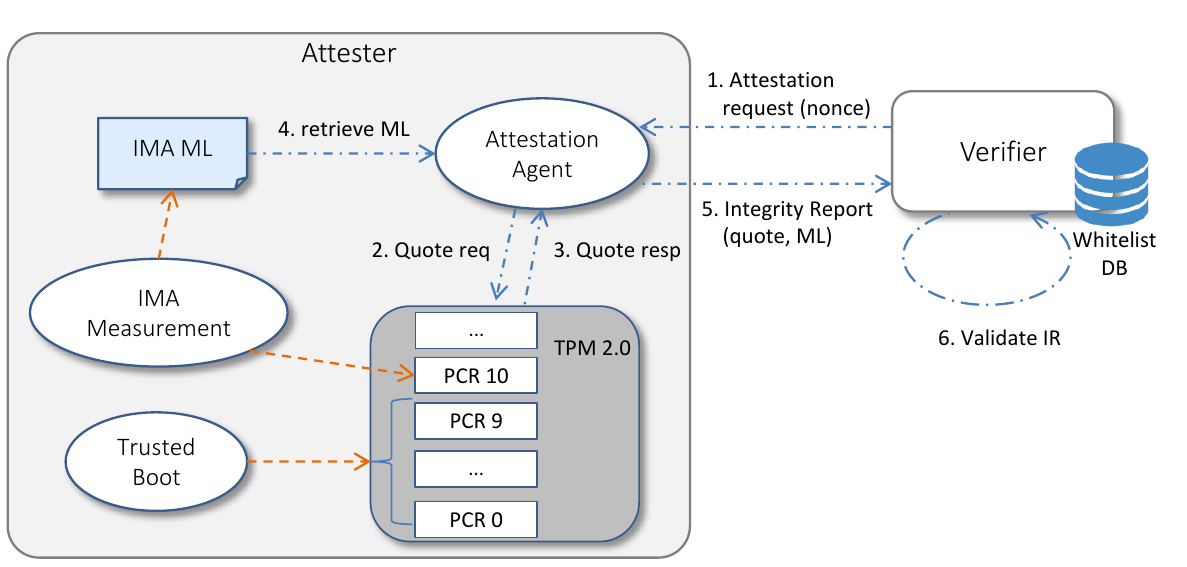
Figure 3. IMA-based Remote Attestation